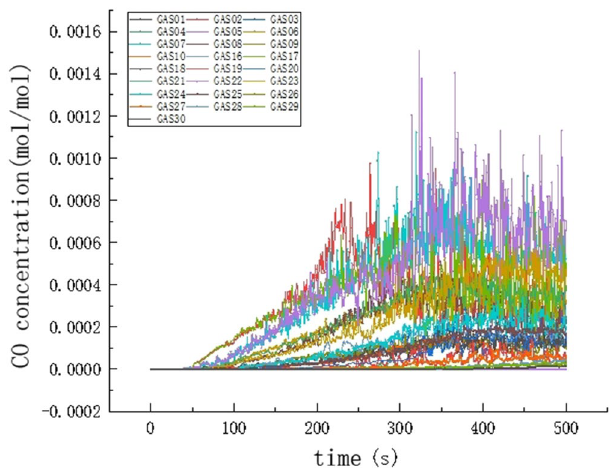
Figure 9. Curve of CO concentration change.